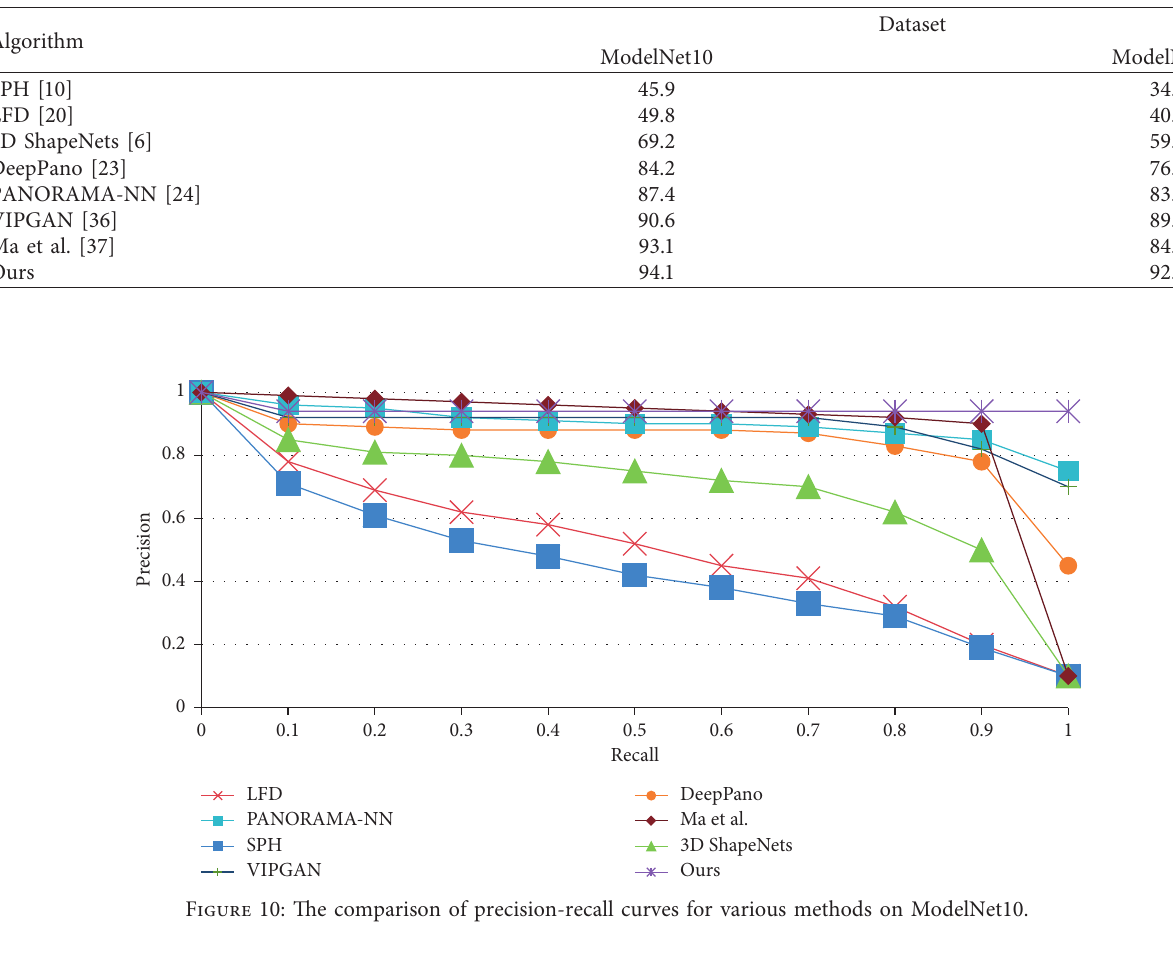
Table 6: The comparison of the proposed method and other methods (MAP,